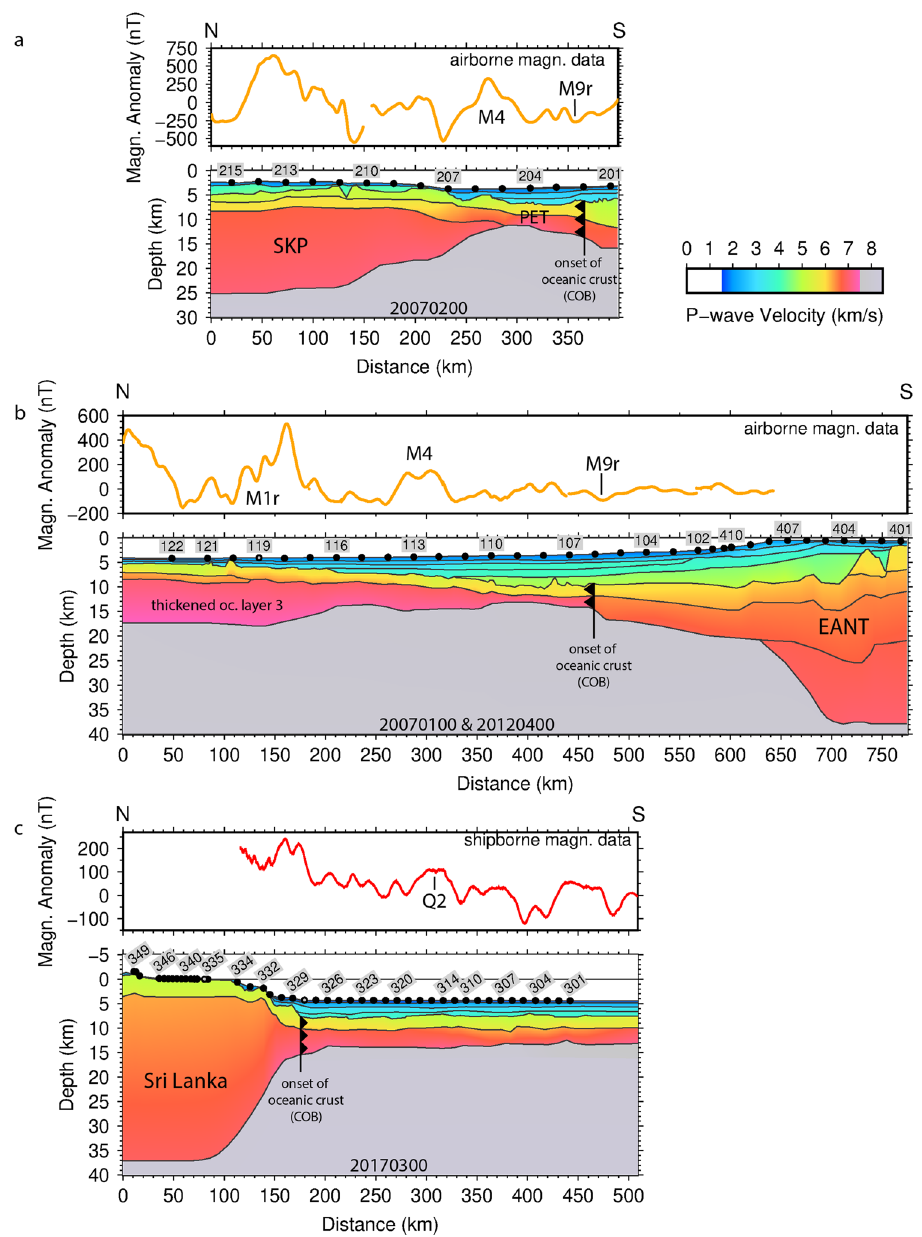
Figure 2. P-wave velocity profiles and magnetic data acquired across the Princess Elizabeth Trough ( a ), off Prydz Bay ( b ), and south of Sri Lanka ( c ). All plots: Generic Mapping Tools 36 . The upper panels display the newly acquired magnetic data along each line, the lower panels the P-wave velocity models. The positions of OBSs, OBHs and land stations are marked by black circles. Lost stations and stations with serious malfunctions are marked by grey circles. Numbers above the stations indicate the OBS/OBH/land station number. Selected magnetic chrons (e.g. M4, M9r) are added to the magnetic data based on identifications from this study. Accordingly, the onset of oceanic crust is marked. Profiles are shown at a common scale. The PET and PB velocity models are aligned at their COBs to highlight the spreading rate differences between them. Details of ray coverage, misfits and uncertainties can be found in the Supplementary Figures S2–S10 and Supplementary Table S11. Further details will be published elsewhere. Abbreviations: COB-continent-ocean boundary (onset of oceanic crust), EANT-East Antarctica, oc-oceanic, PET-Princess Elizabeth Trough, SKP-Southern Kerguelen